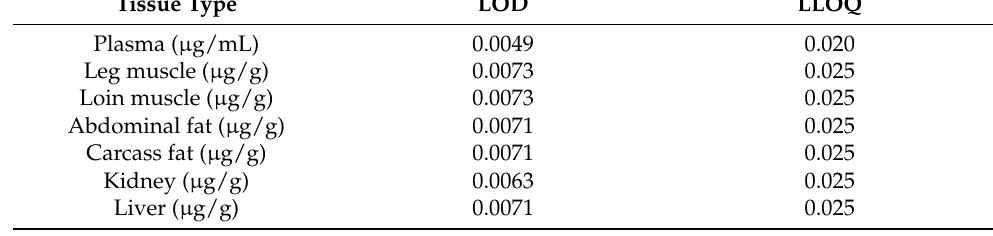
Table 1. Limit of detection (LOD) and lower limit of quantification (LLOQ) values. Data represents the high-performance liquid chromatography method used to quantify meloxicam concentrations in plasma and tissue samples from sheep following administration of single or multiple oral doses of 1 mg/kg meloxicam tablets dissolved in water.